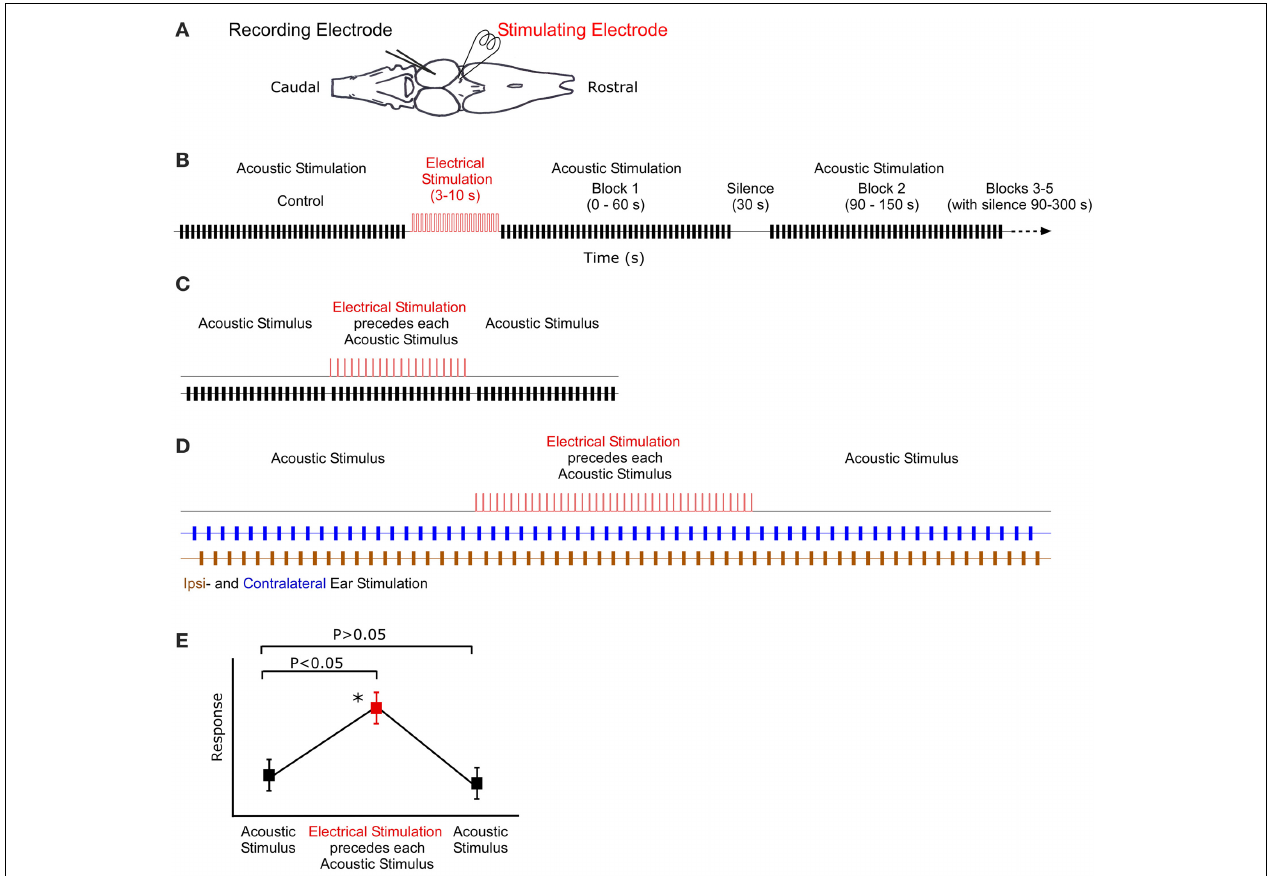
FIGURE 1 | Illustration of recording, stimulation and analysis techniques. (A) Dorsal view outline of the frog brain. Recording and stimulating electrodes are in the midbrain and thalamus, respectively. (B) Stimulus protocol for long-term stimulation. Control block of acoustic stimuli (black) are followed by 10s of electrical stimulation (red). Subsequent blocks of acoustic stimuli (and silence) follow at particular intervals. (C) Sound-by-sound electrical